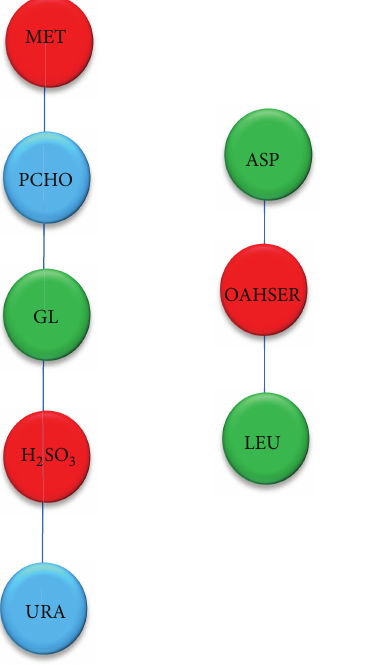
Figure 7: Key metabolites network on PC2; there are 8 key met abolites in PC2 network, 5 and 3 nodes in each subnetwork. These key metabolites can be used as PC2 to separate the sample group taken from ethanol culture from glycerol culture. Since there are 3 different patterns of changing in metabolite profile, these nodes are shown in 3 different colors; red (increasing), (decreasing), and blue (nonmonotonous or